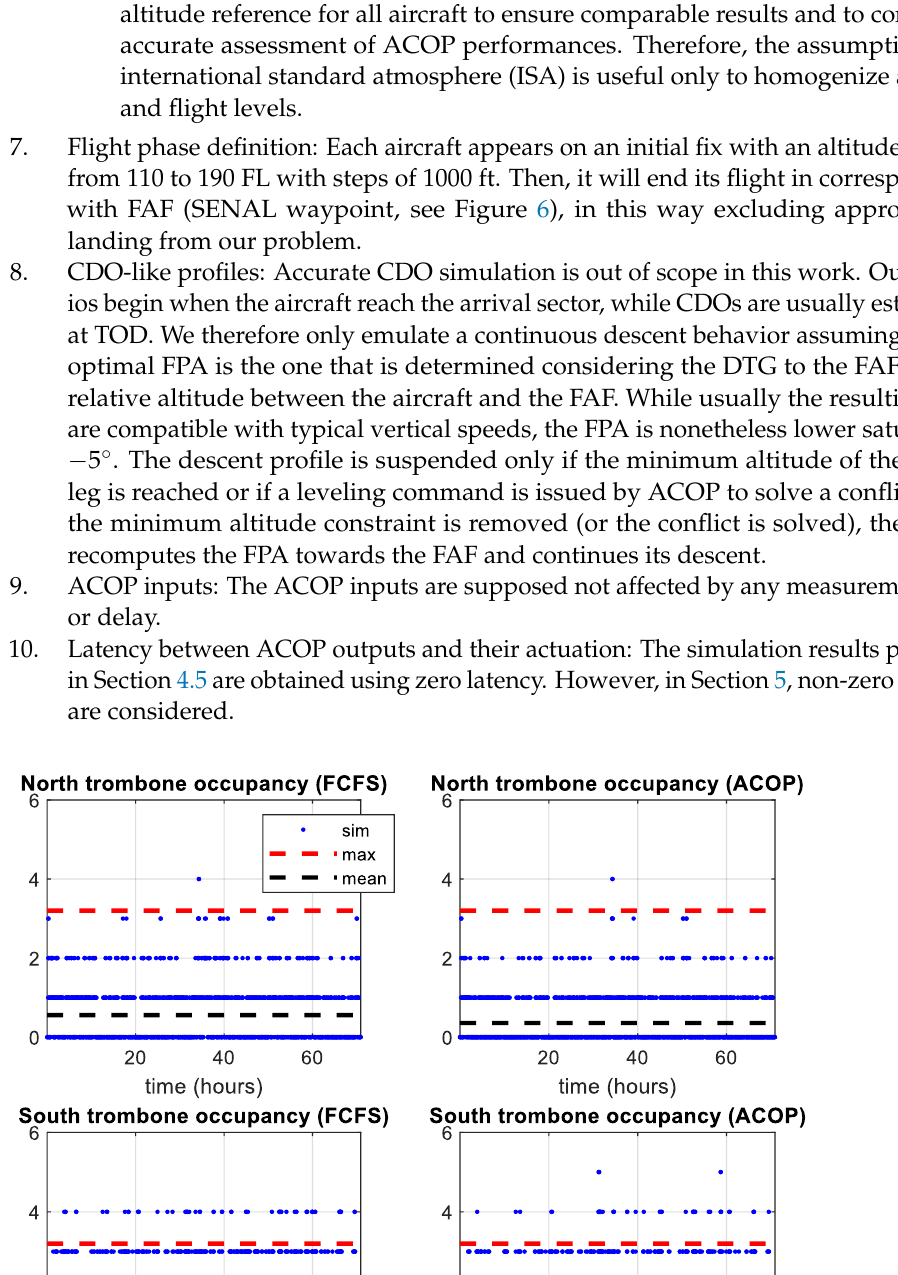
Figure 9 . CTA arrival times distribution.